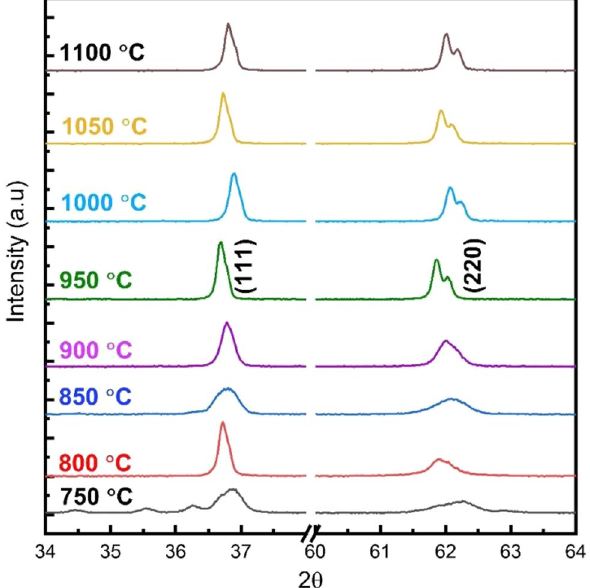
Fig. 6 XRD patterns of ( a ) ball-milled (BM) powder, ( b ) HEO powder calcined at 950 °C, and ( c ) HEO pellet sintered at 1200